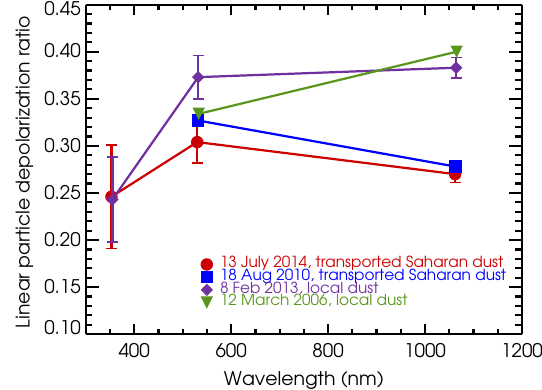
Figure 9. The linear particle depolarization ratio measured by HSRL-2 and HSRL-1 for the four dust cases discussed in the text. Note the spectral dependence (and in particular the 1064nm chan- nel) is different for the two local dust-dominated aerosol cases com- pared to the transported Saharan dust-dominated aerosol